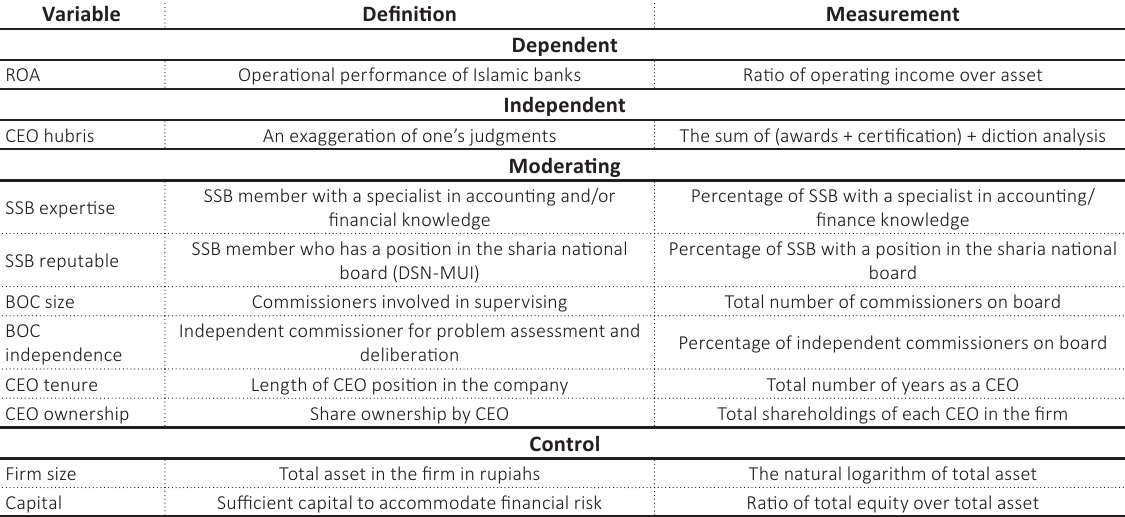
Table 2. Variable definition and their measurement